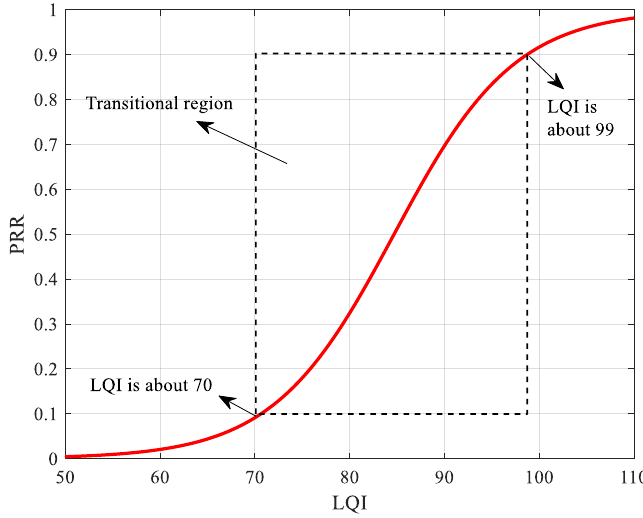
Figure 2. Fitting Model of LQI and PRR.